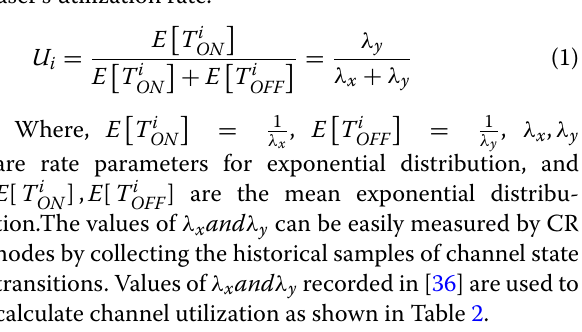
that indicate the erroneous sensing report caused when CR user discovers the channel ON at time ( t ), but one CR neighbor discovers the channel OFF at time ( t ) and completed a transmission on channel during ( t − (cid:2) t , t ) . The FA state is expressed by the vector (101). The cor- rect ON cluster comprises the samples